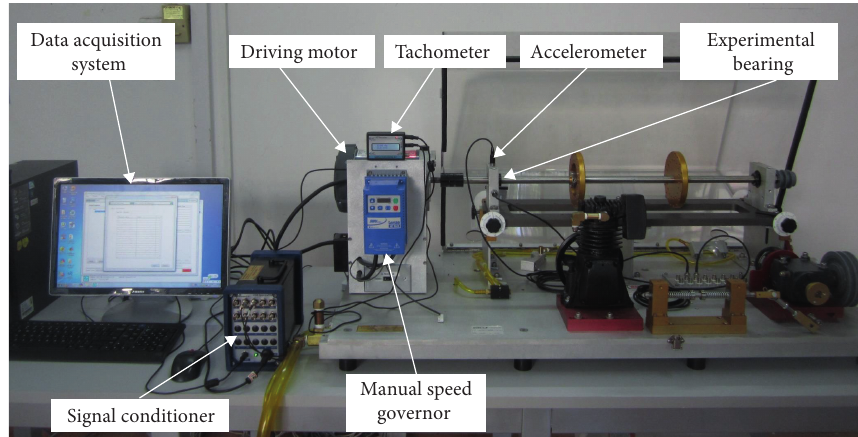
Figure 7: The MFS-MG test rig.